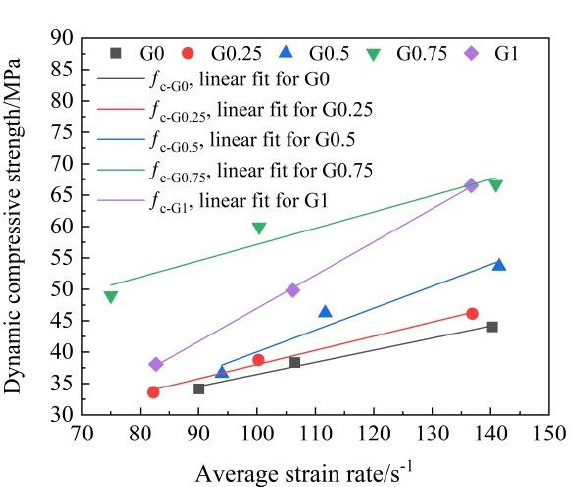
Figure 6. Relationship between dynamic compressive strength and average strain rate of alkali-re- sistant glass fiber slag mortar. sistant glass fiber slag